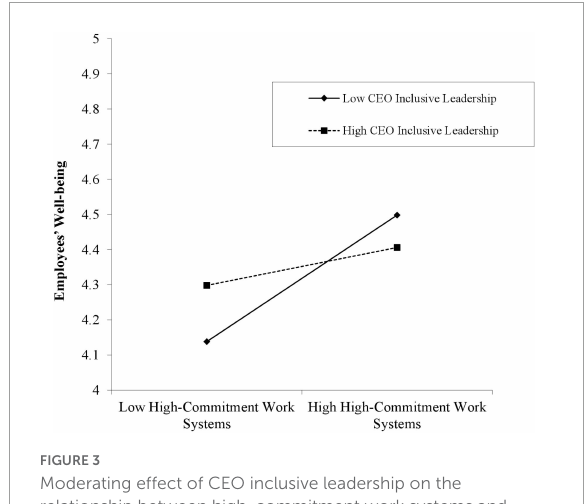
FIGURE3 Moderating effect of CEO inclusive leadership on the relationship between high-commitment work systems and employees’